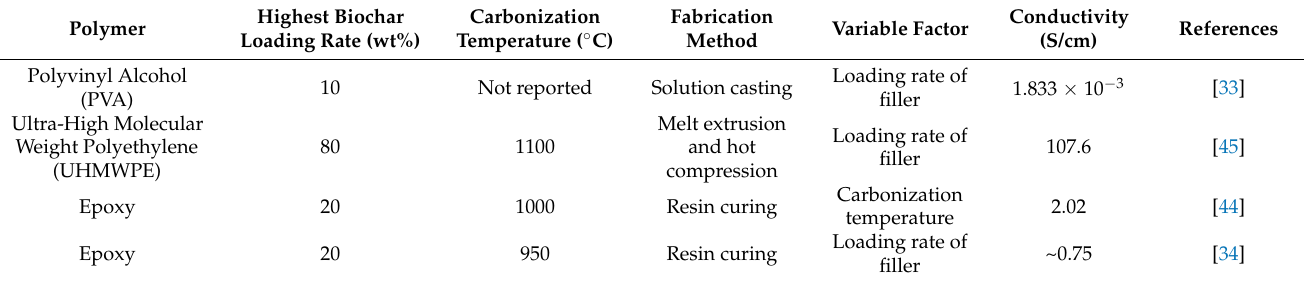
Table 3. Electrical conductivity values reported for biochar filled polymer composites. Highest Biochar Carbonization Fabrication Polymer Variable Loading Rate (wt%) Temperature ( ◦ C) Method